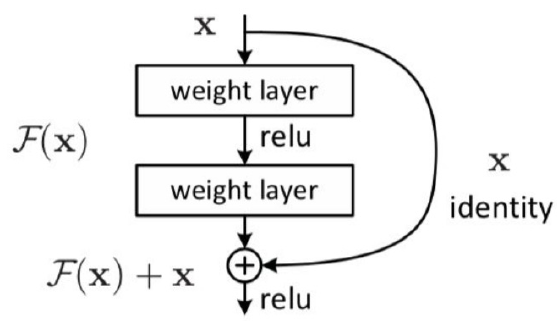
Figure 3. Residual block.